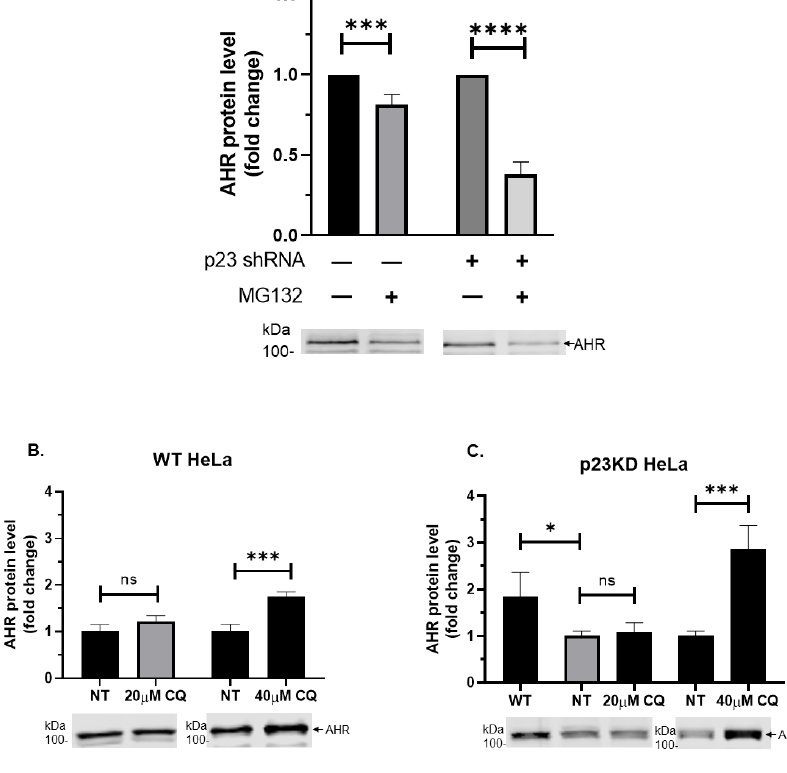
Figure 1. Using an autophagy inhibitor or activator to reveal that the aryl hydrocarbon receptor (AHR) undergoes autophagy in wild type (WT) and p23 stable knockdown (p23KD) HeLa cells. ( A ) MG132 (10 μ M for 6 h) decreased AHR protein levels more in HeLa cells transiently transfected with p23 shRNA (2.5 μ g for 48 h) than in WT HeLa cells. EndoFectin transfection reagent (2:1) was used. The below images are representative of the replicate data (means ± SD, n = 4). Conditions with no MG132 treatment were arbitrarily set as one (with no error bar) for data normalization. Multiple t -tests corrected with the Holm-Sidak method for multiple comparisons were performed to determine statistical significance. ( B ) WT and ( C ) p23KD HeLa cells were treated with 20 μ M or 40 μ M chloroquine (CQ) dissolved in water for 6 h. Western analysis results showed a higher increase